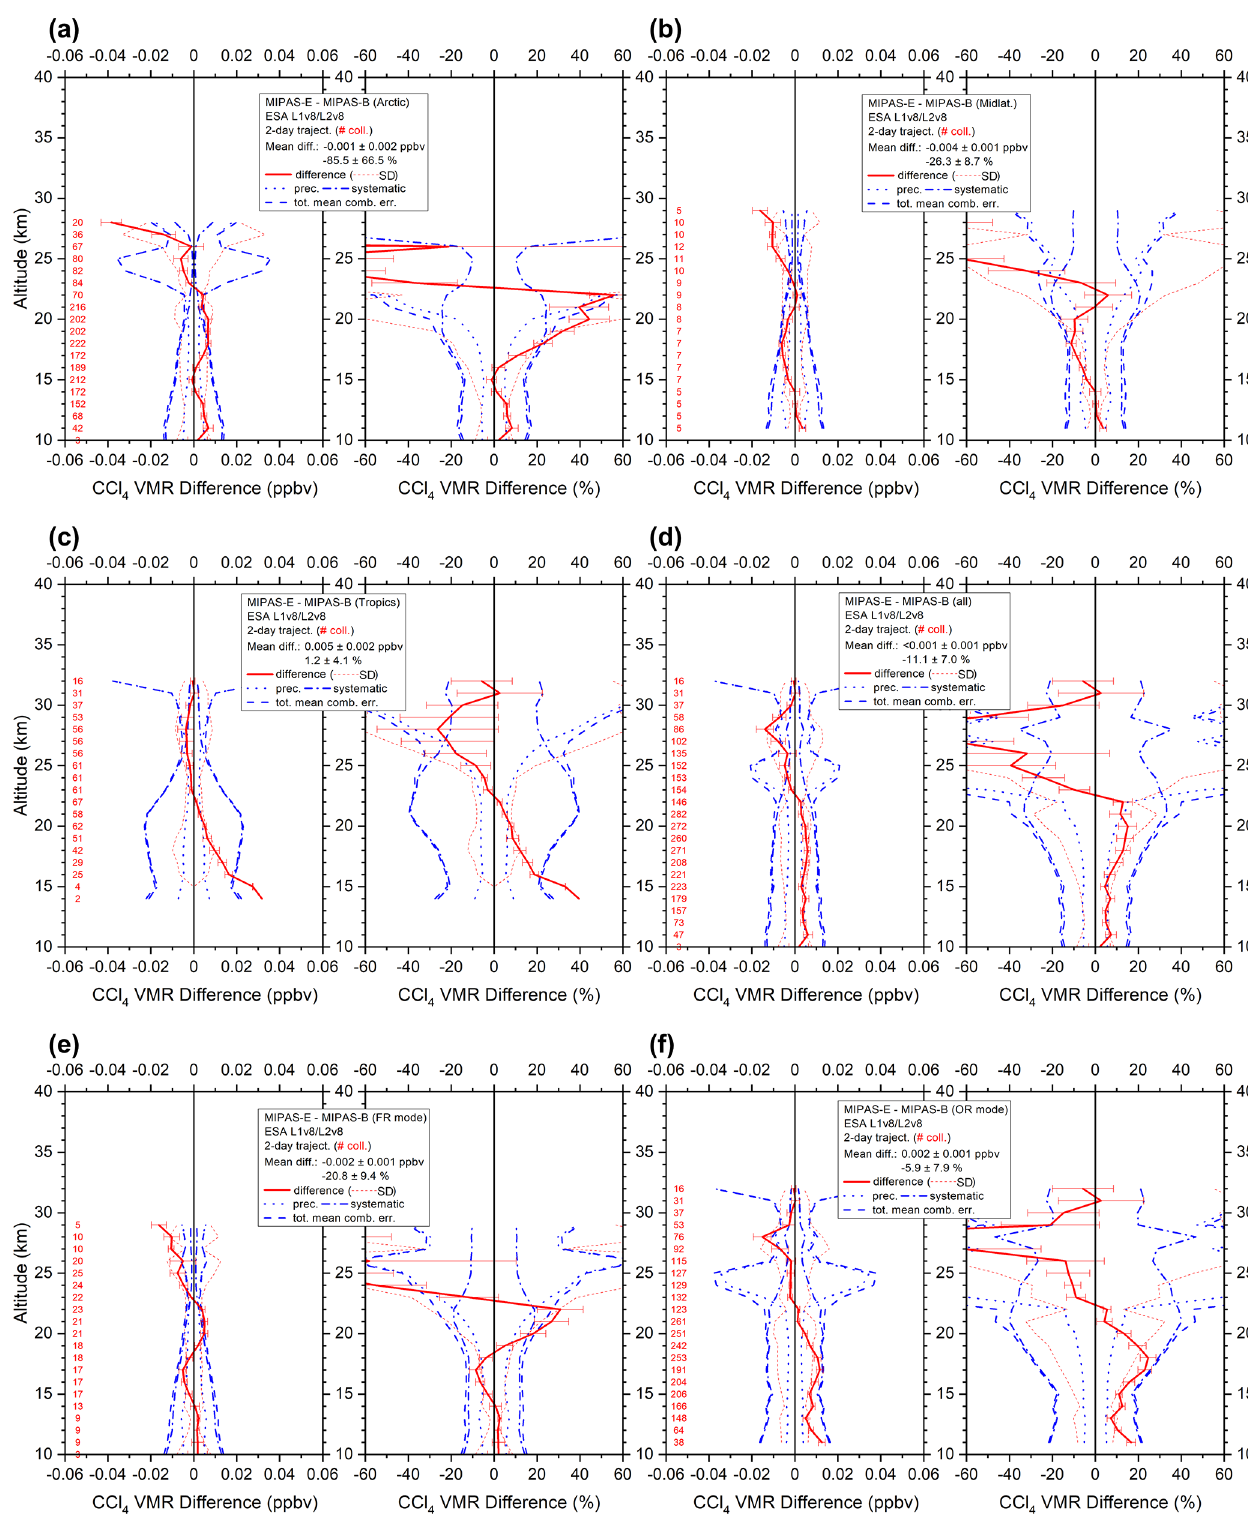
Figure 14. Same as Fig. 3 but for CCl 4